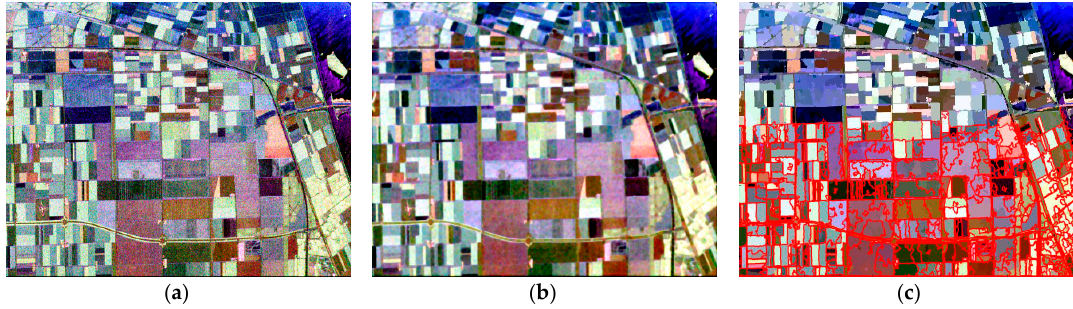
Figure 3. The Pauli-RGB imagery of AIRSAR after speckle filtering and GSRM segmentation: ( a ) The Pauli-RGB imagery of original AIRSAR imagery; ( b ) The Pauli-RGB imagery of AIRSAR after speckle filtering; ( c ) The Pauli-RGB imagery of AIRSAR after GSRM segmentation.